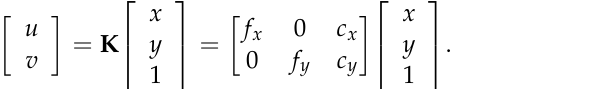
In the main text below Figure 8. "on the same level as a result from KITTI dataset" can be corrected to "on the same level as the result from KITTI dataset".